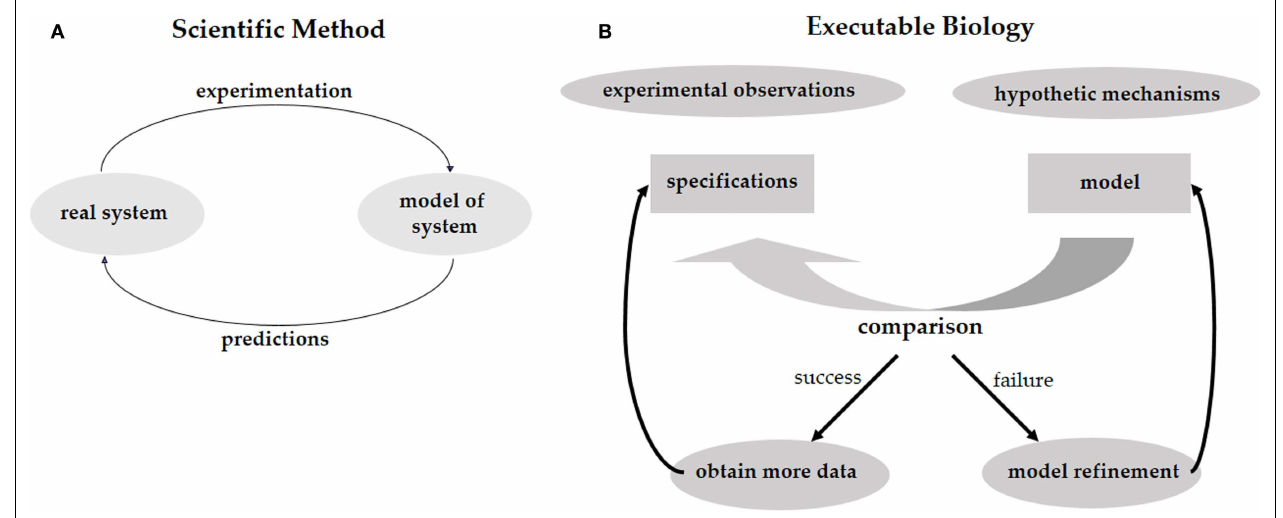
process for executable biology calls for the elaboration of a model in the form of a computer program.The model is compared with specifications obtained from experimental observations. Failure to reproduce the experimental results leads to a refinement of the model. Predictions are used to guide further